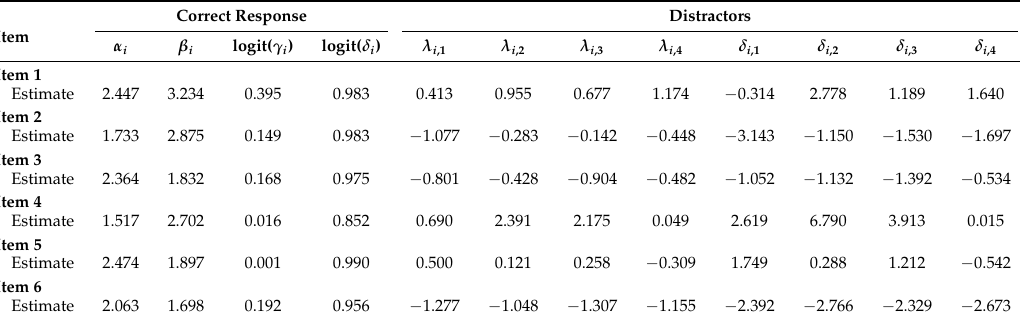
Table 6. Item parameters of the 4PNL